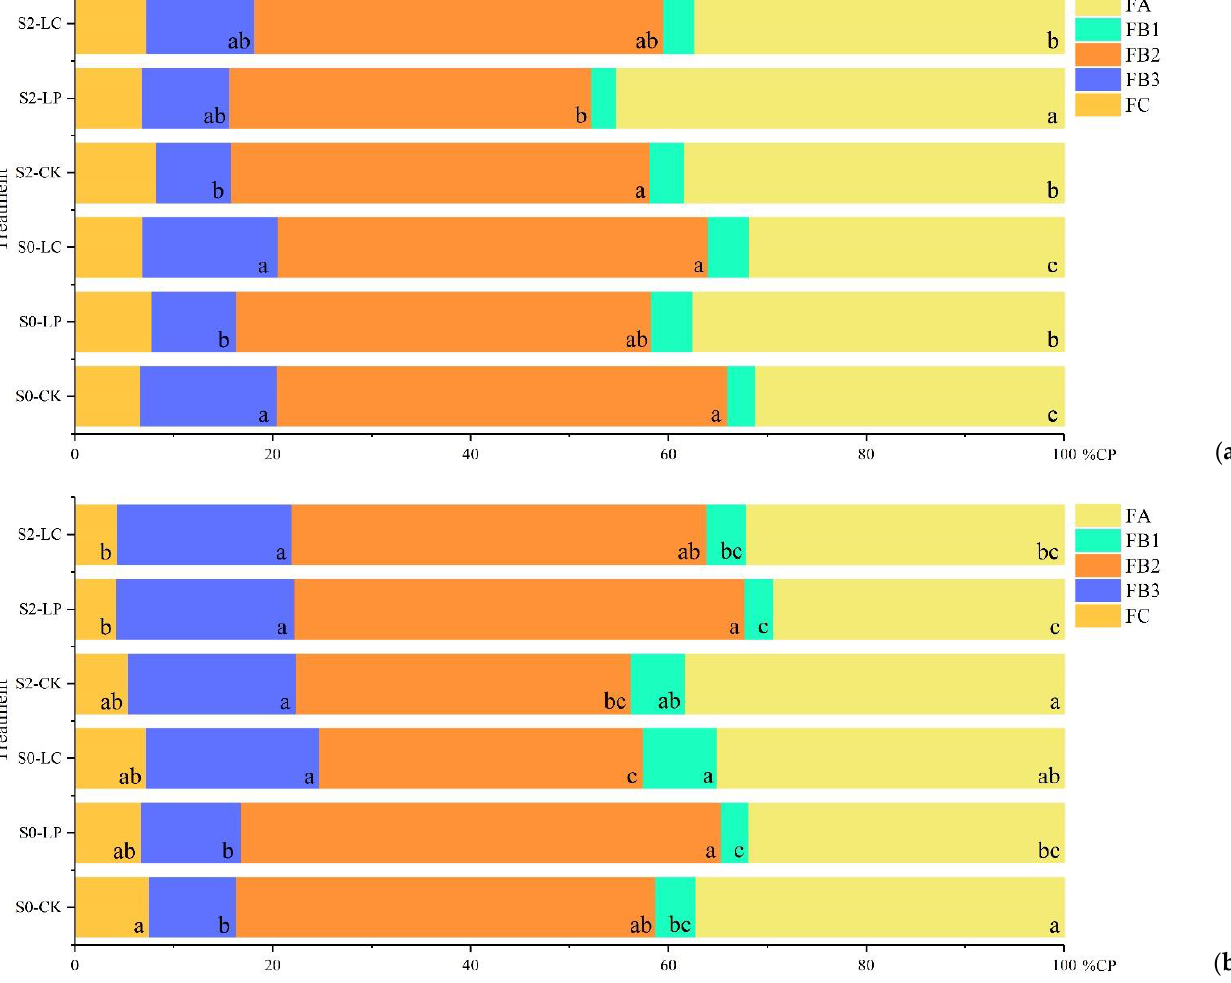
Figure 1. Protein fractions of leaf silage in paper mulberry ( a ) and mulberry ( b ). Different letters differ significantly from each other ( p < 0.05) for the same color patch in each kind of silage. S0, ensiling without sucrose; S2, ensiling with 20 g /kg sucrose on a fresh matter basis; CK, ensiling without lactic acid bacteria additives; LP, ensiling with Lactobacillus plantarum at the level of 10 6 cfu/g of fresh matter; LC, ensiling with Lactobacillus casei at the level of 10 6 cfu/g of fresh matter; FA, fraction A; FB1, fraction B1; FB2, fraction B2; FB3, fraction B3; FC, fraction C.